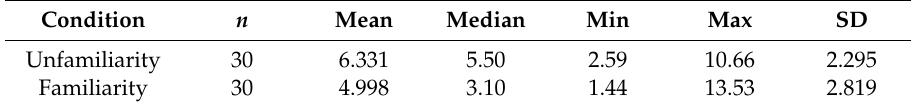
Table 13. Descriptive statistics for the product search times.